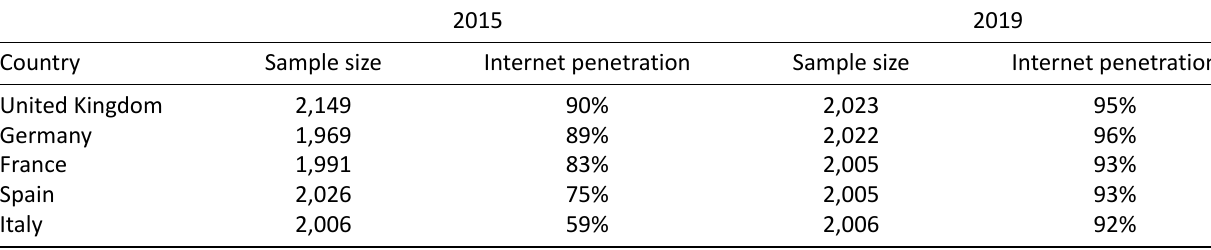
Table 1. Sample size and internet penetration (2015 and